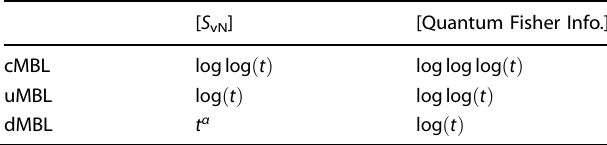
Table 1. Hierarchies of dynamic characteristics encompassing constrained, unconstrained, and diagonal MBL